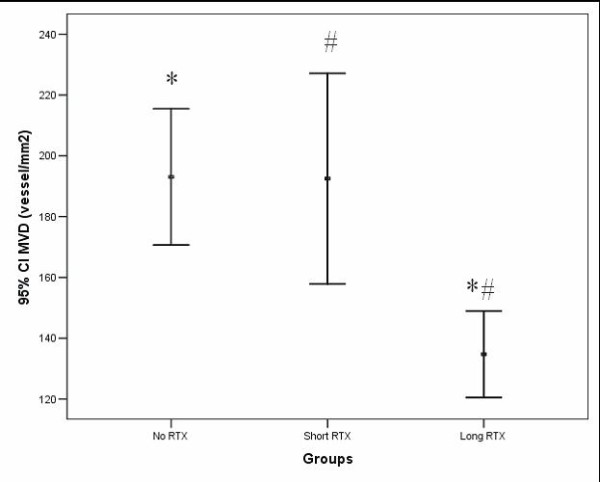
Differences of mean ± SE of MVD (microvessel/mm2) in untreated (no RTX), short term (short RTX) and long term RTX (long RTX) groups. F = 6.726; df = 2; p* = 0.002, p# = 0.034.